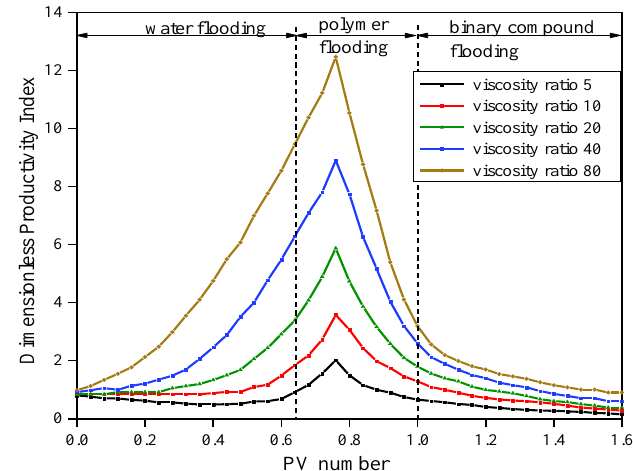
Figure 5. The variation in the dimensionless productivity index with the PV number injected under different water – oil viscosity